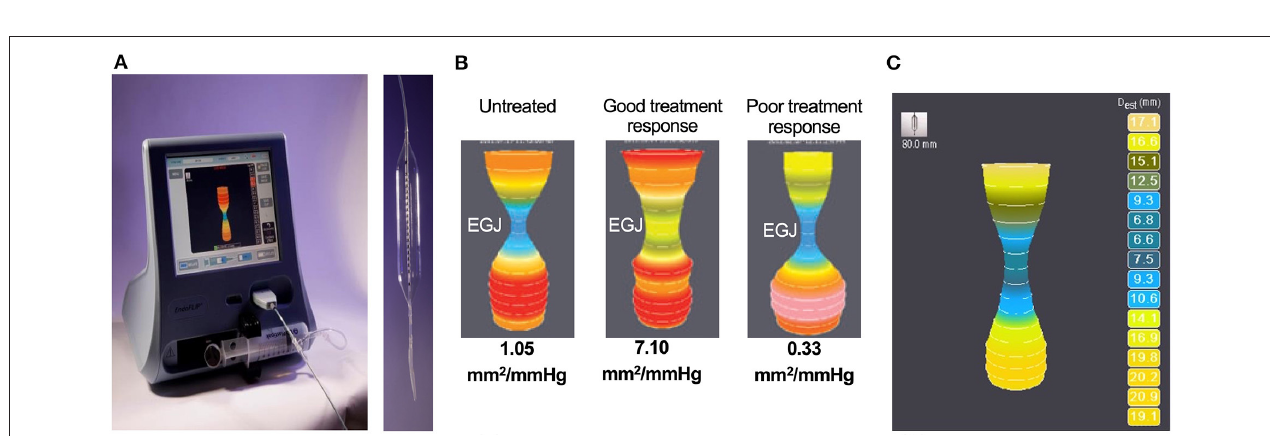
FIGURE 11 | Endoluminal Functional Lumen Imaging Probe (EndoFLIP). (A) Image of the Endoluminal Functional Lumen Imaging Probe (EndoFLIP) machine and catheter with a soft balloon at the distal end. The EndoFLIP system uses impedance planimetry to map out the geometry of cross-sectional areas of the esophagus and esophagogastric junction (EGJ). (B) Intra-operative EndoFLIP images assessing the EGJ in human patients with achalasia pre and post Heller myotomy. The left image shows a patient pre-treatment with a narrowed EGJ. The middle image shows a patient with a good response to myotomy with an improved EGJ diameter. The right image shows a patient with a poor response to myotomy given the persistently narrowed EGJ. (C) Hourglass shape image generated by the EndoFLIP balloon catheter spanning the EGJ in a brachycephalic dog with a history of regurgitation. The numbers on the right indicate the diameter (in millimeters) read out at each 1cm mark along the length of the 8cm